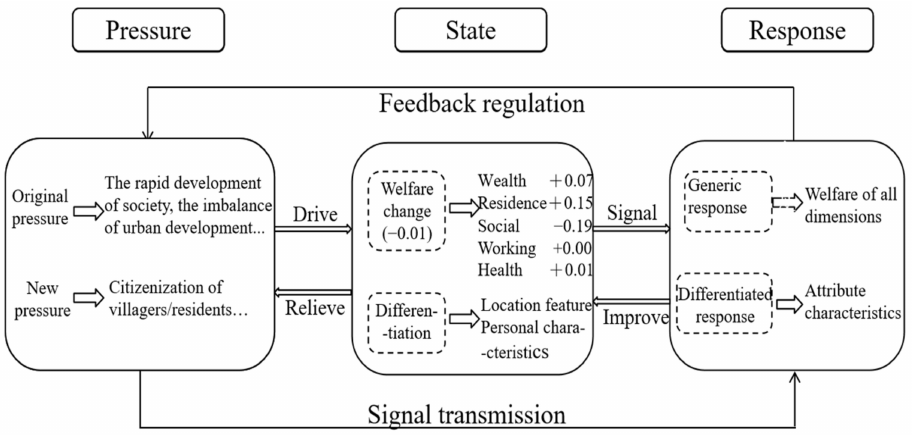
Figure 5. Analysis model of sustainable regeneration process based on micro-investigation in